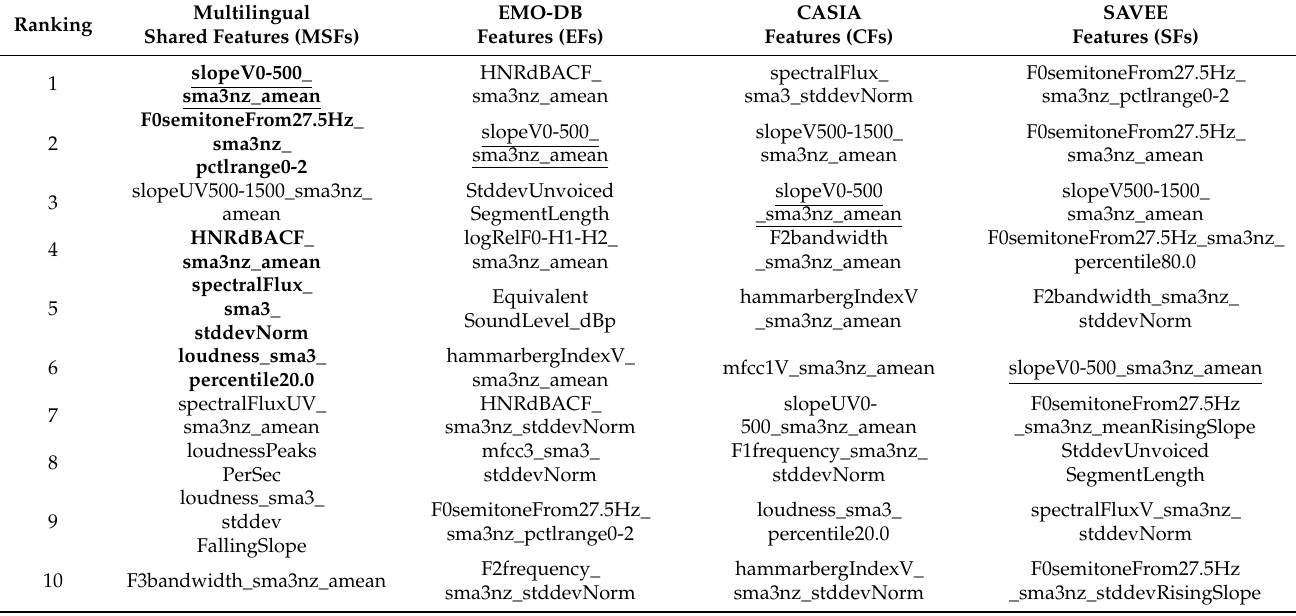
Table 7. Feature ranking based on attention